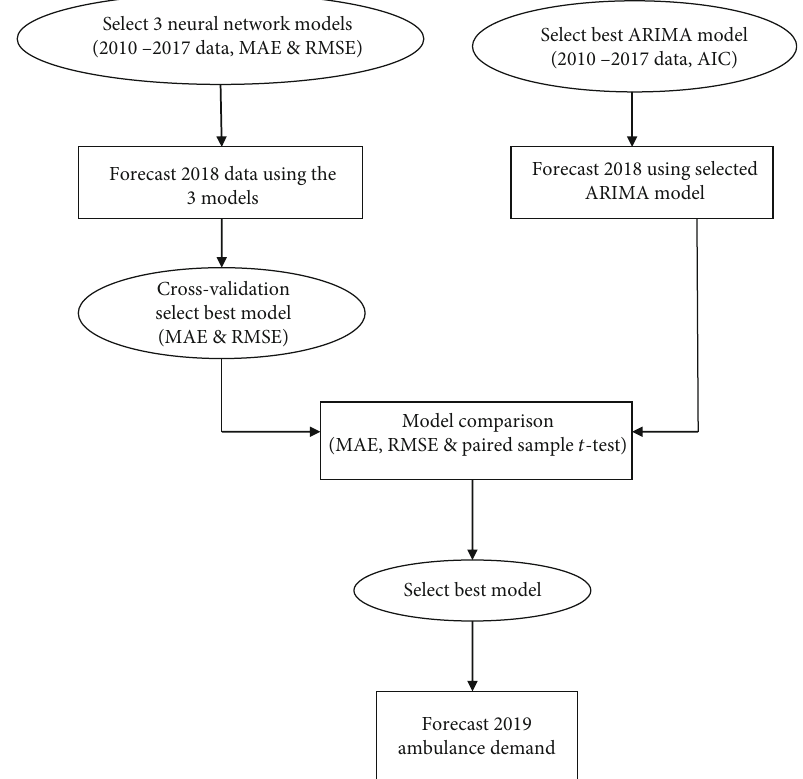
Figure 2: Model building and selection